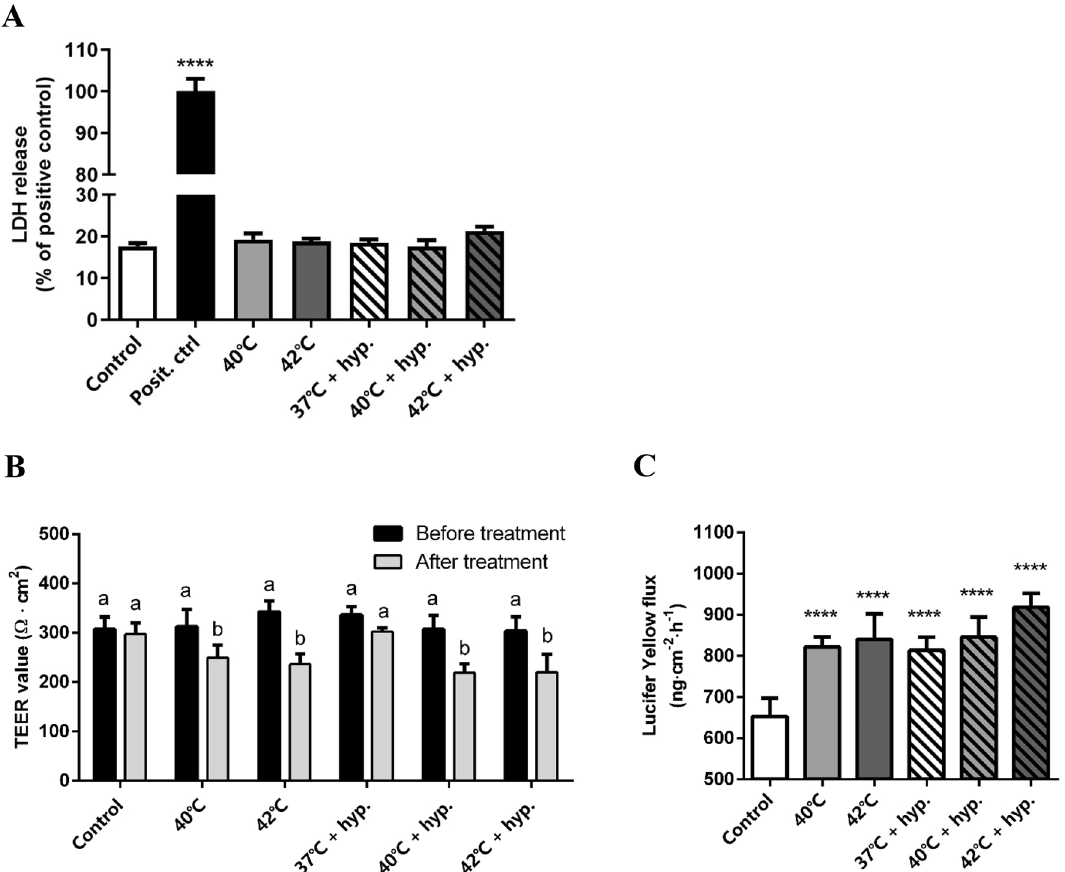
Figure 2. Effects of hypoxia ± heat treatment on cell viability and monolayer integrity in the co-culture of Caco-2 and HT-29 cells. ( A ) LDH release of Caco-2 and HT-29 cells co-culture after 2 h of hypoxia ± heat treatment. In the positive control group, the cells were lysed with lysis buffer. ( B ) TEER values of the co-culture monolayer before and after 2 h of hypoxia ± heat treatment. ( C ) Lucifer Yellow permeability assay of the co-culture monolayer after 2 h of hypoxia ± heat treatment. All values were presented as means ± SEM (N = 3, n = 3). Statistical differences were analyzed by two-way ANOVA followed by the Bonferroni’s multiple comparison test. **** p < 0.0001; significant different from control ( A , B and D ). Means without a common letter differ at p < 0.05 ( C ). posit. ctrl positive control; hyp.